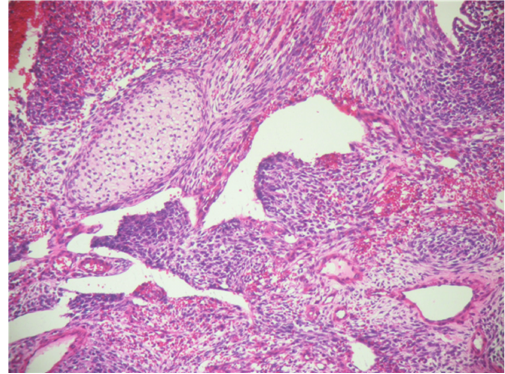
Figure 5: Cartilaginous foci in adenosarcoma.